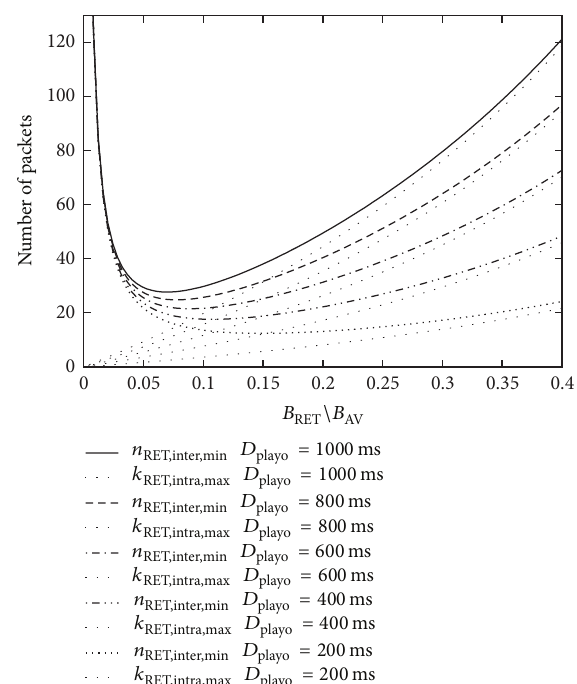
Figure 6: Intra- and interburst